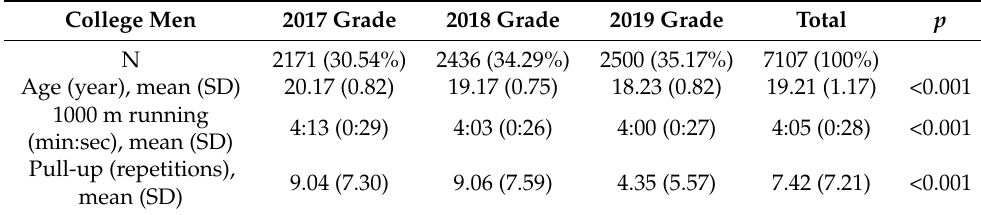
Table 1. The baseline characteristics of the sample in the 2019